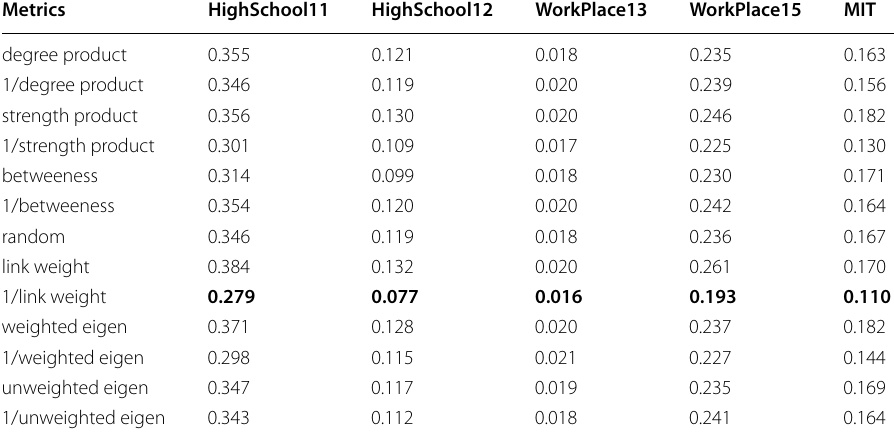
Table 10 The peak height i.e. the highest prevalence over time, when the recovery rate is 10% per day, and φ = 10% of the contacts are removed from each temporal network using removal